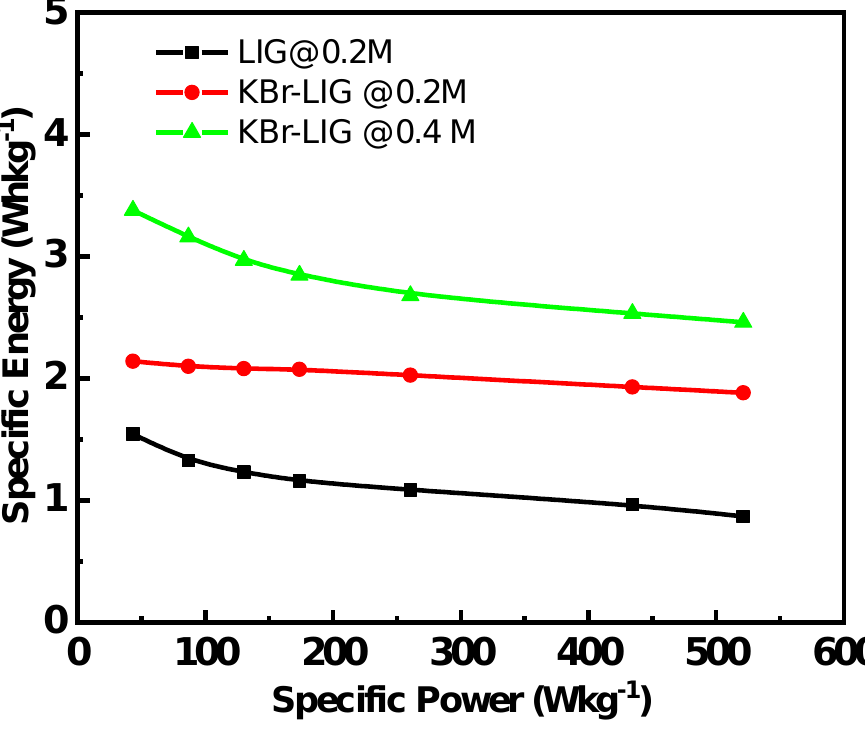
Figure 8. Specific energy versus specific power for the supercapacitor for both LIG and KBr-LIG. Table 2. A comparison between different active electrodes prepared by direct laser scribing on a polyimide sheet.